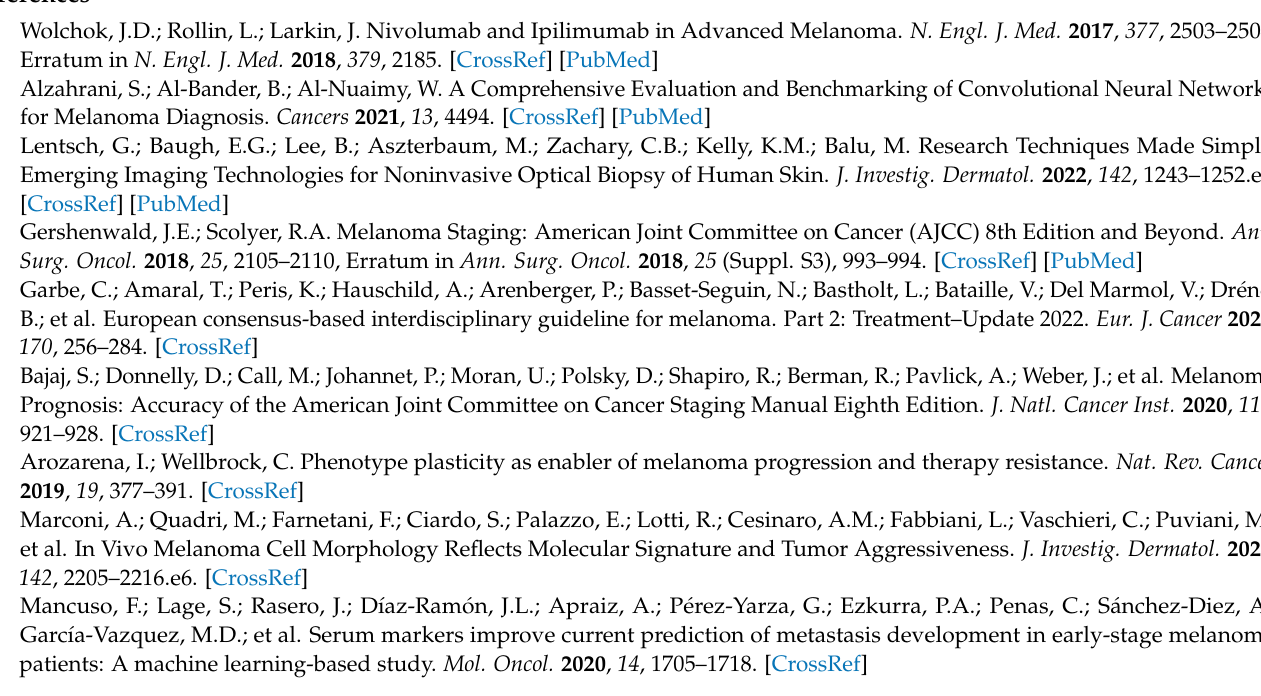
(Figure 6B). Figure S4: Screenshots from the Melanoma CDSS application. Table S1: Summary of the bioinformatics and machine learning studies of risk factors included in the Melanoma CDSS. Table S2: Summary of the algorithms used in the prognosis module of the Melanoma CDSS. Table S3: Parameters selected in each algorithm used in the prognosis module of the Melanoma Clinical Decision